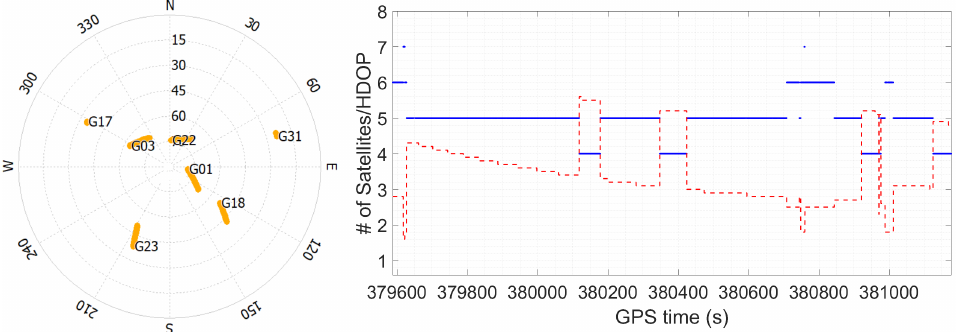
Figure 4. Skyplot and Horizontal Dilution of Precision (HDOP) for test 1 (steering on).